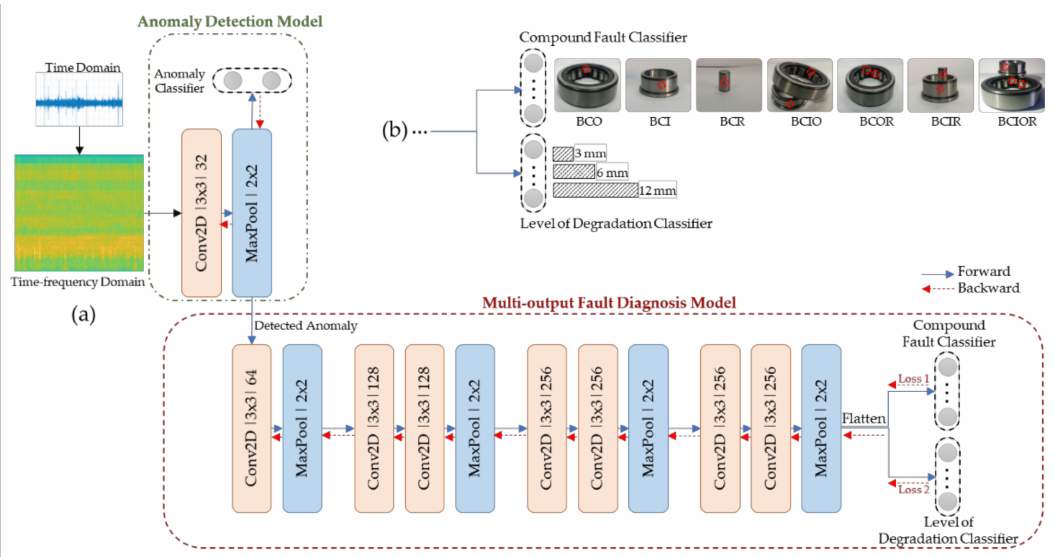
Figure 1. ( a ) Proposed CNN-based multi-output classification framework (Conv2D|x|y means 2D CNN|kernel size|channels; Maxpool means Max pooling operation); ( b ) Illustration of two classifiers for two diagnosis aims: compound fault types: Outer raceway (BCO), Inner raceway (BCI), Roller (BCR), Inner and outer raceway (BCIO), Outer raceway and roller (BCOR), Inner raceway and roller (BCIR), Inner and outer raceway and roller (BCIOR); Crack size: 3, 6, 12